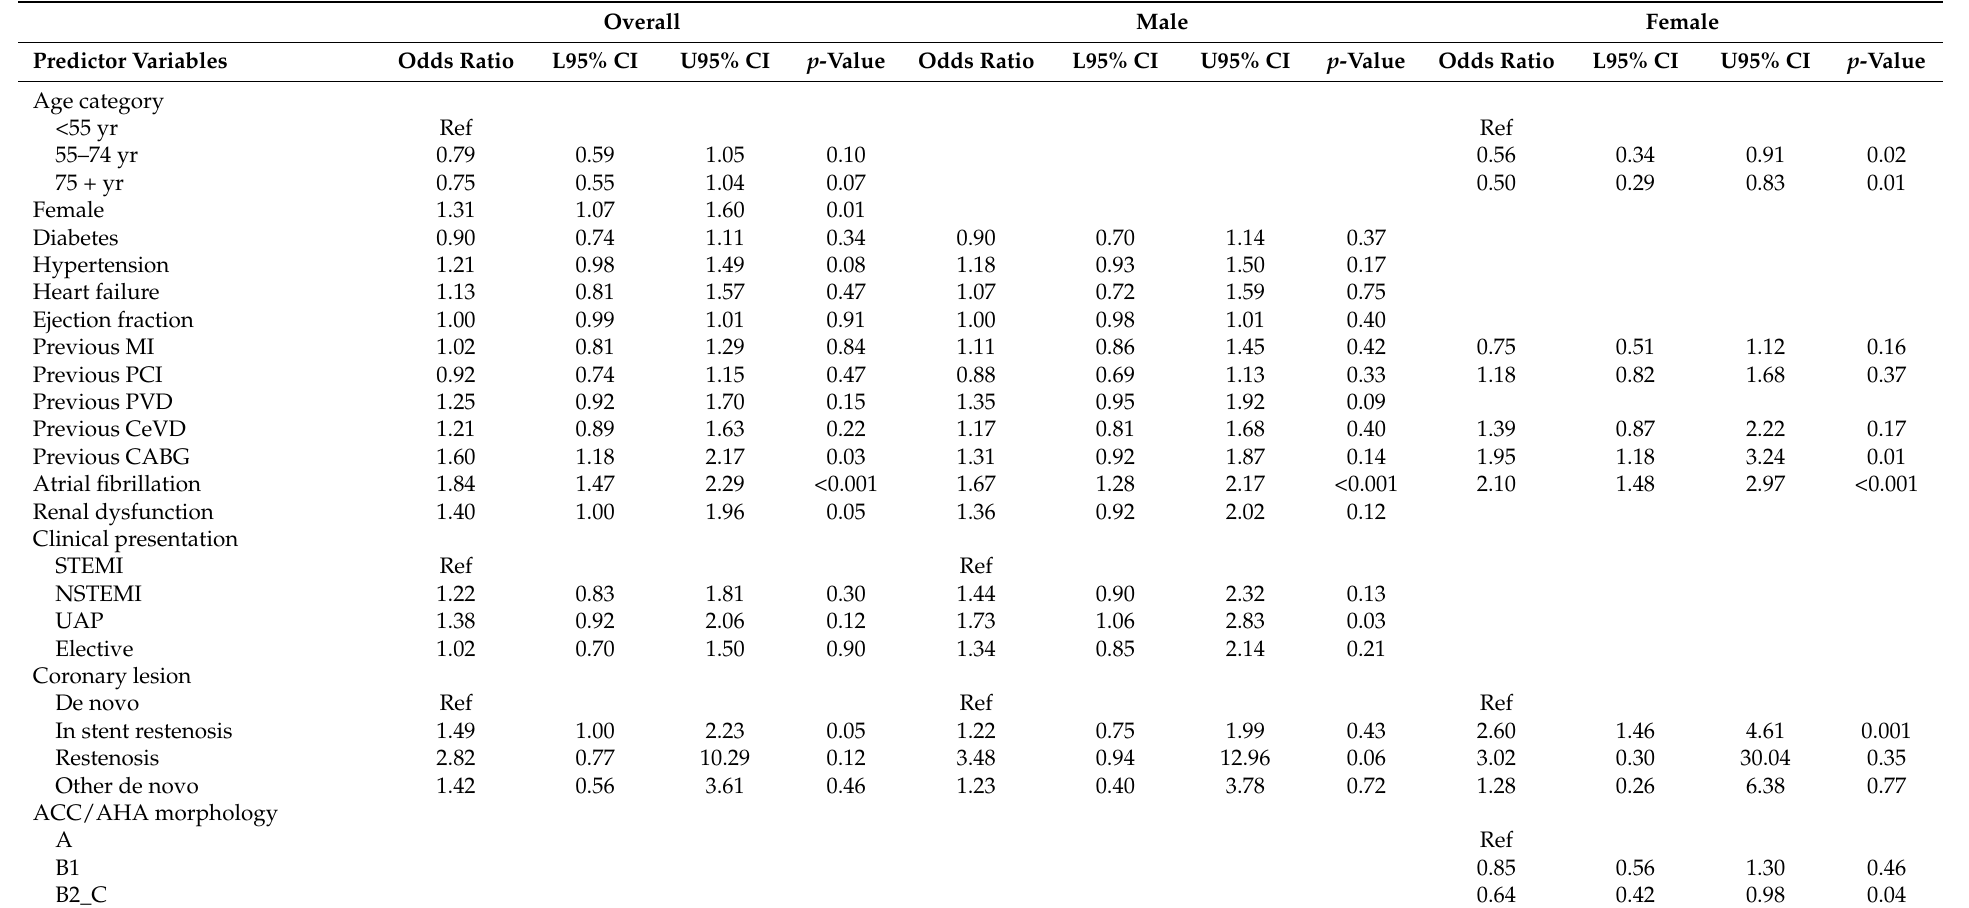
Table 3. Predictor of unplanned readmission (the first) according to multivariate analysis. Overall Male